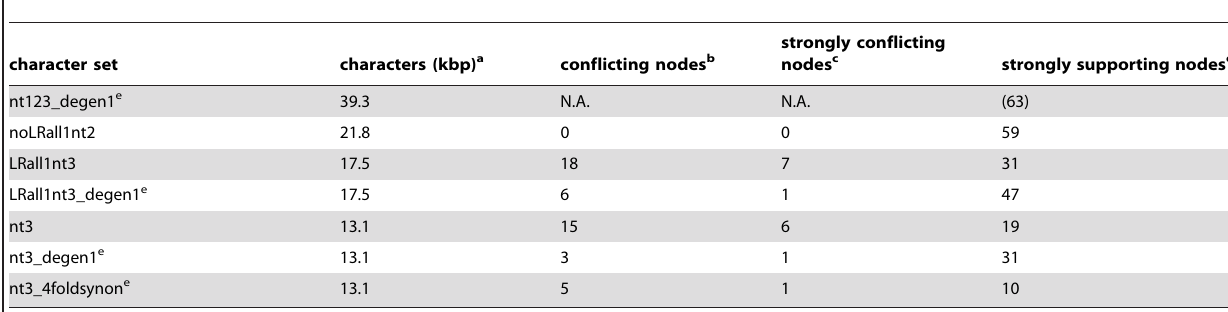
Table 4. Comparison of synonymous and nonsynonymous change in terms of node recovery and node support.